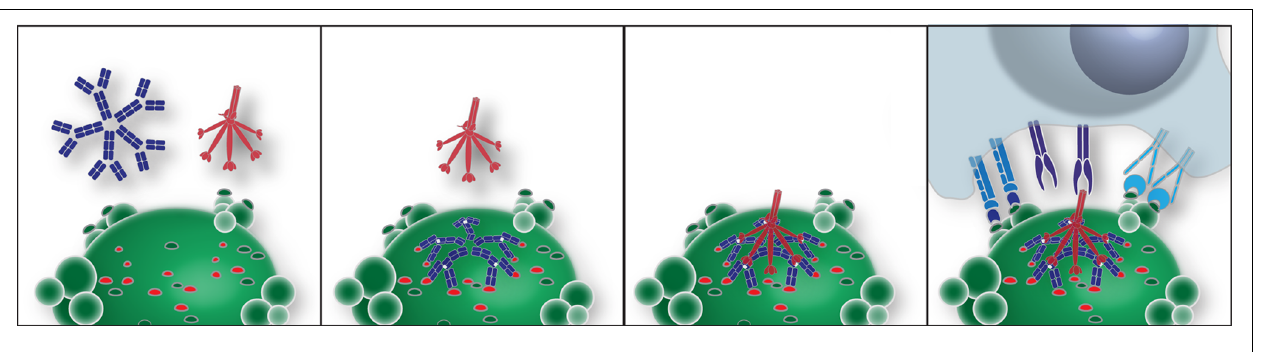
conformational site responsible for recruitment of the globular heads of C1q (Czajkowsky and Shao, 2009). Alternatively, MBL binds to nearby high mannose N-linked glycoconjugates on mu-associated sites (not shown).This polymeric IgM–C1q complex is involved in generating or stabilizing interactions with receptors on professional phagocytes, which enhance apoptotic phagocytosis and blocks inflammatory